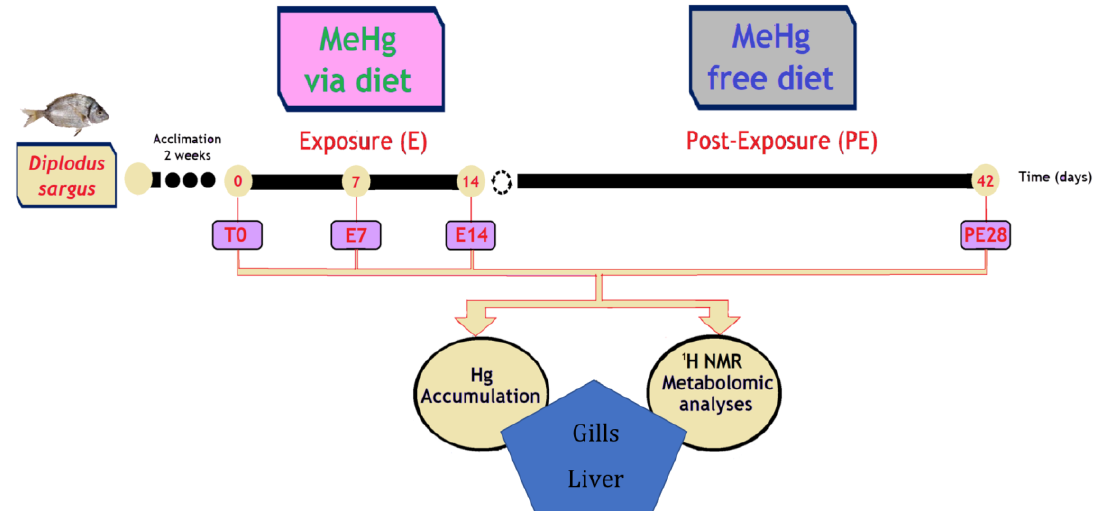
Figure 1. Experimental design with white seabream, Diplodus sargus , comprising an acclimation time of 2 weeks (T0) followed by an exposure period to MeHg via diet for 7 (E7) and 14 days (E14). Thereafter, fish were fed with a MeHg-free diet for 28 days (Day 42; PE28) to allow recovery. In parallel, control groups of fish were also considered. At each experimental time, gills and liver were collected to measure levels of Hg and to perform a metabolomic analysis.